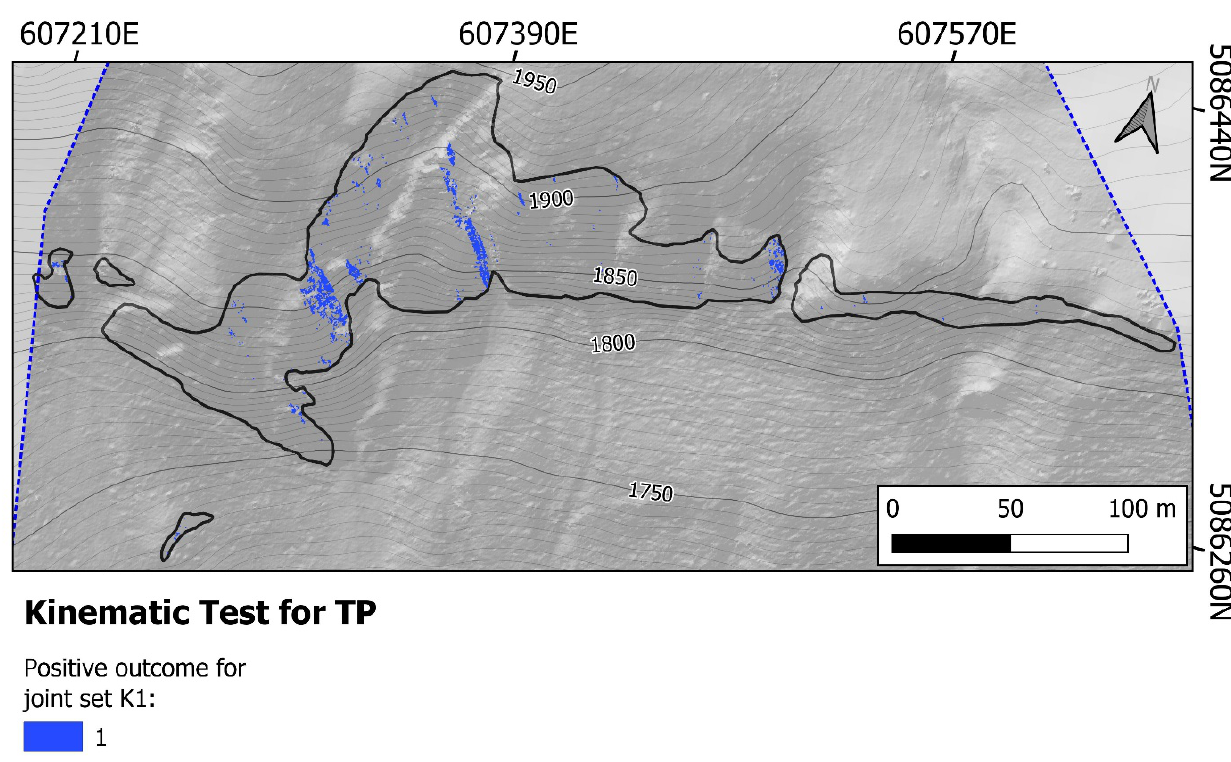
Figure A11. Image of the partial output file showing the kinematic test for TP performed considering only joint set K1.